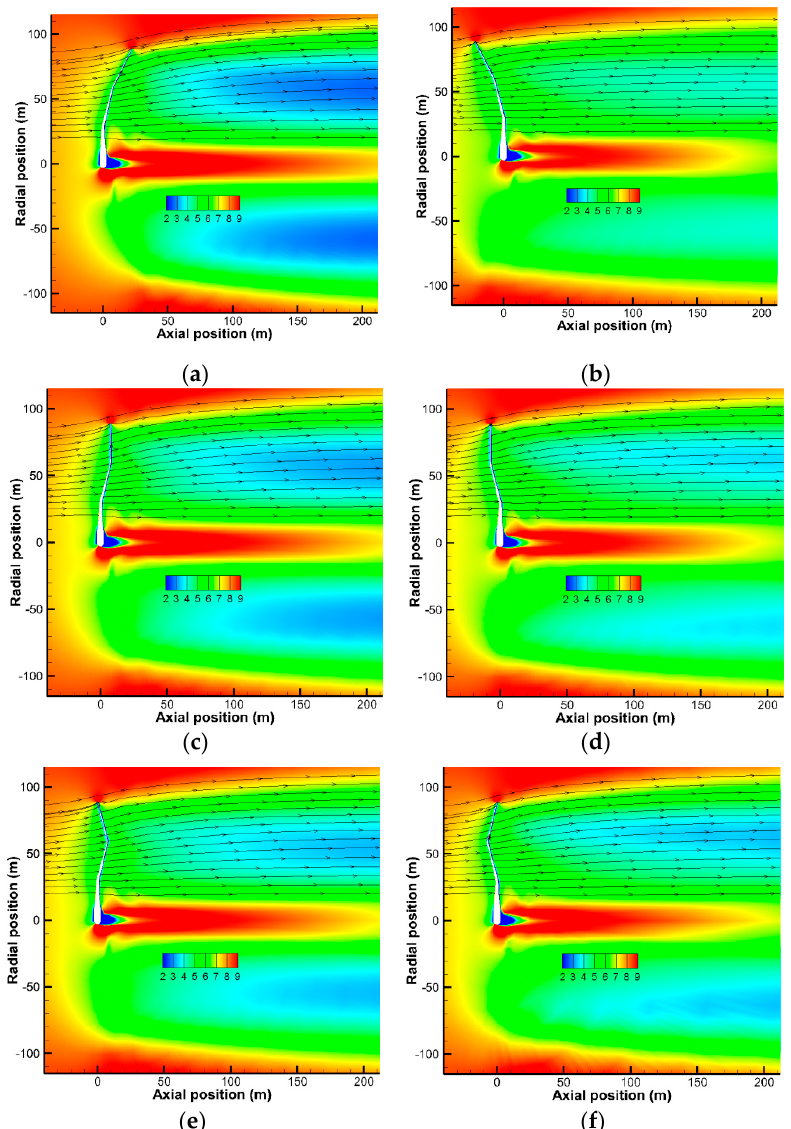
Figure 12. Streamline in the YZ plane with axial velocity contours: ( a ) C4S2; ( b ) C-4S2; ( c ) C4S0; ( d ) C-4S0; ( e ) C4S1; ( f ) C-4S1.